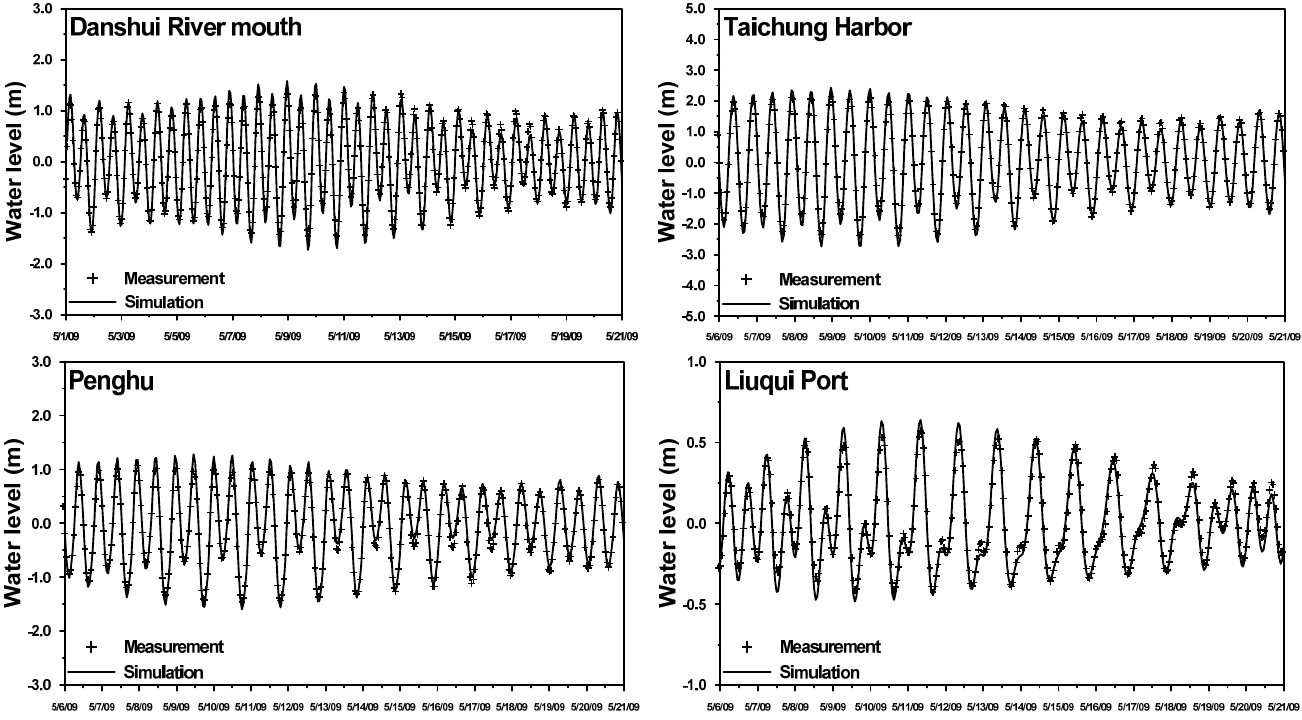
Figure 3. Comparisons between simulated and observed water levels at different tidal stations (shown in Figure 2a).